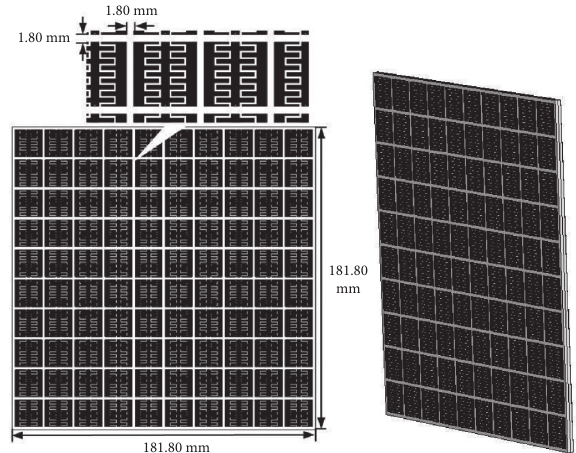
Figure 10: The structure and dimension of array 10 × 10 ICPW-EBG